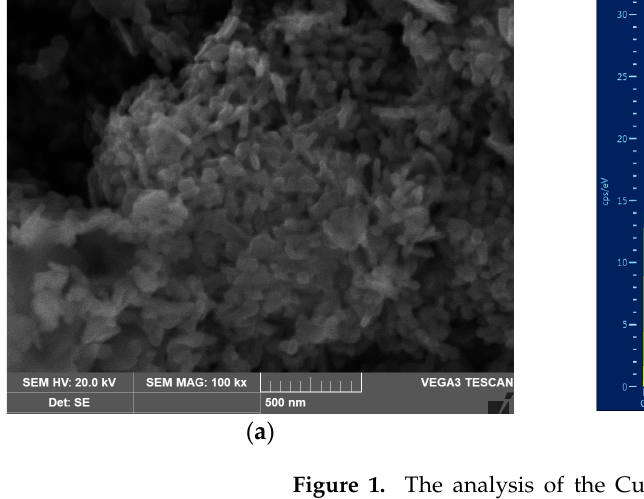
Figure 1. The analysis of the CuO-NP used in this work. ( a ) Scanning electron micrograph. ( b ) Element composition (EDX spectrum).